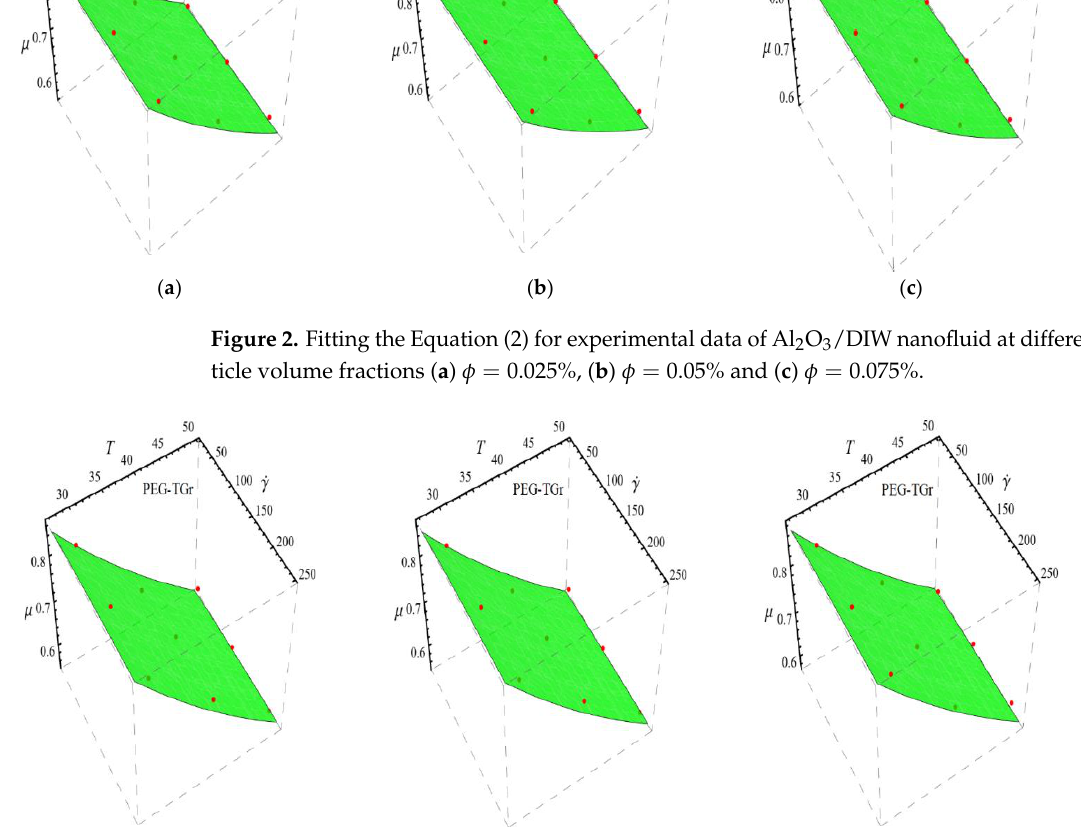
Figure 3. Fitting the Equation (2) for experimental data of PEG-TGr/DIW nanofluid at different nanoparticle volume fractions ( a ) φ = 0.025%, ( b ) φ = 0.05% and ( c ) φ = 0.075%.